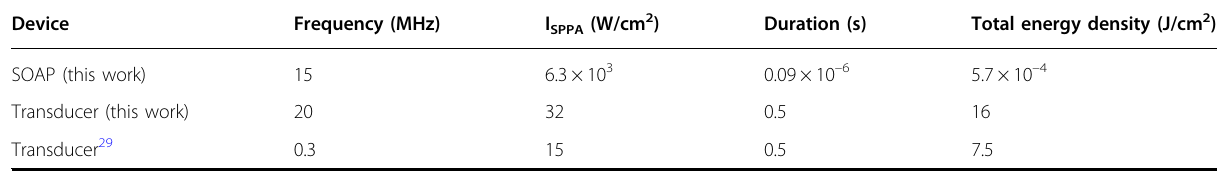
Table 1 Experimental conditions and the total energy density to evoke a similar amplitude of neuron responses